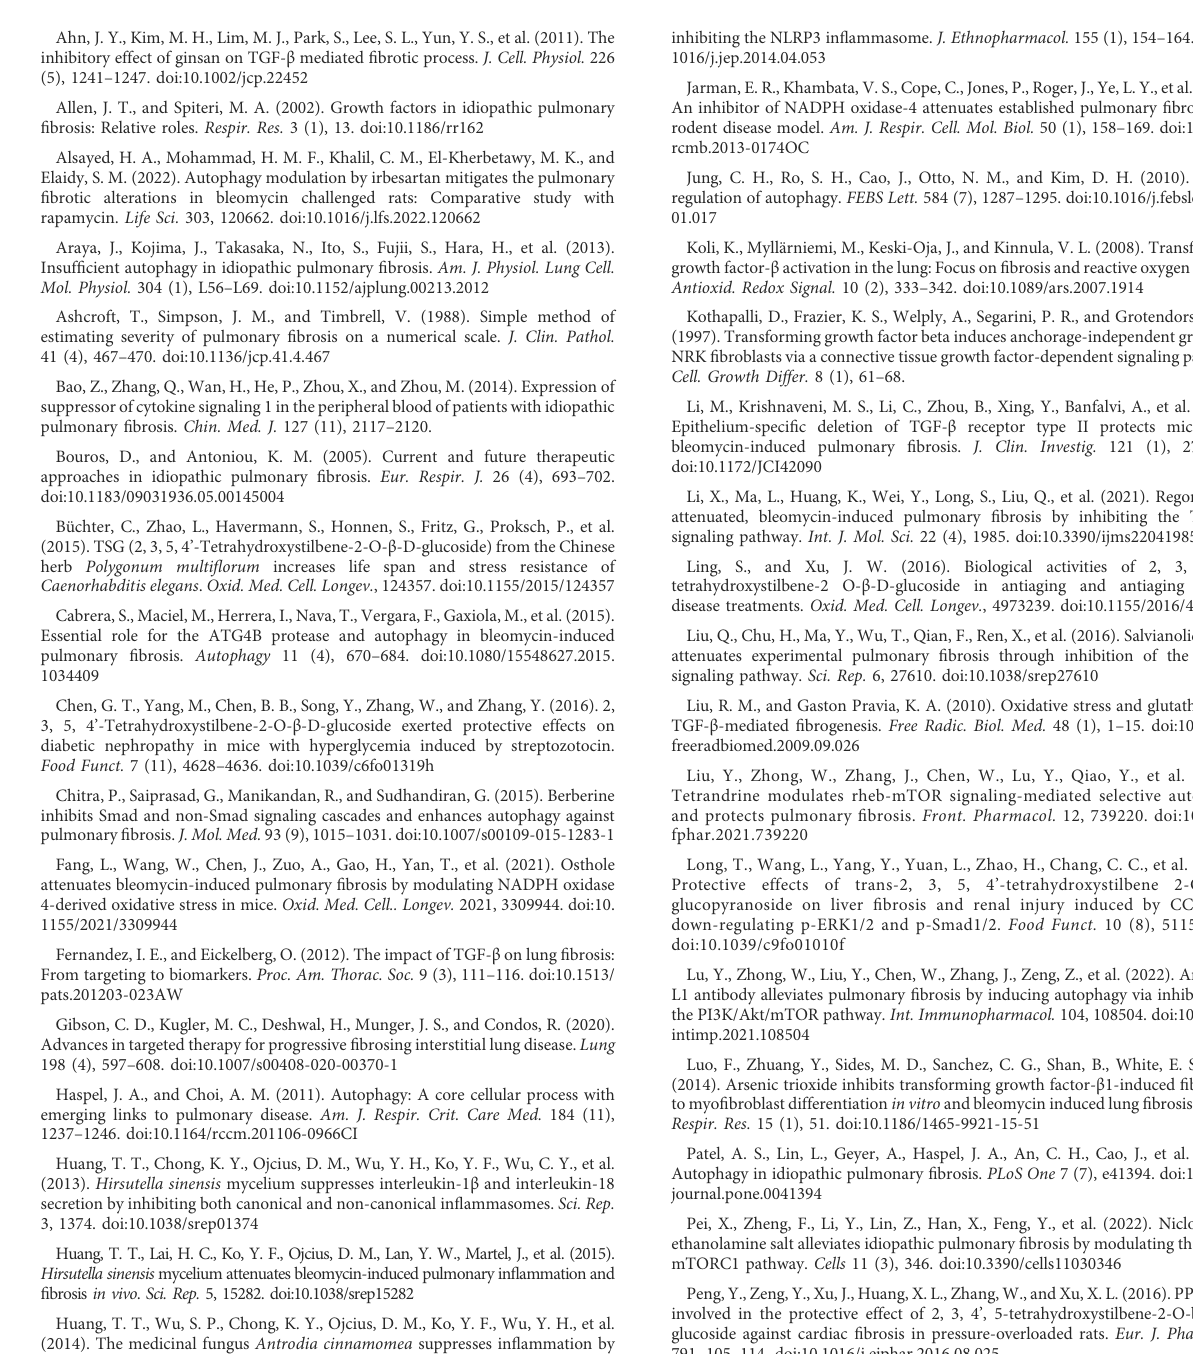
with 5 ng/ml of TGF- β 1 for a further 48 h. The expression of autophagic marker LC3B in whole cell lysates were determined by Western blotting. β -actin was used as a loading control. Representative blots are shown. The relative protein expression level of (B) LC3B-II was quanti fi ed by densitometry and normalized to β -actin. Data are represented as the mean ± SEM of three independent experiments. # p < 0.05 compared with untreated group. * p < 0.05 compared with TGF- β 1-treated